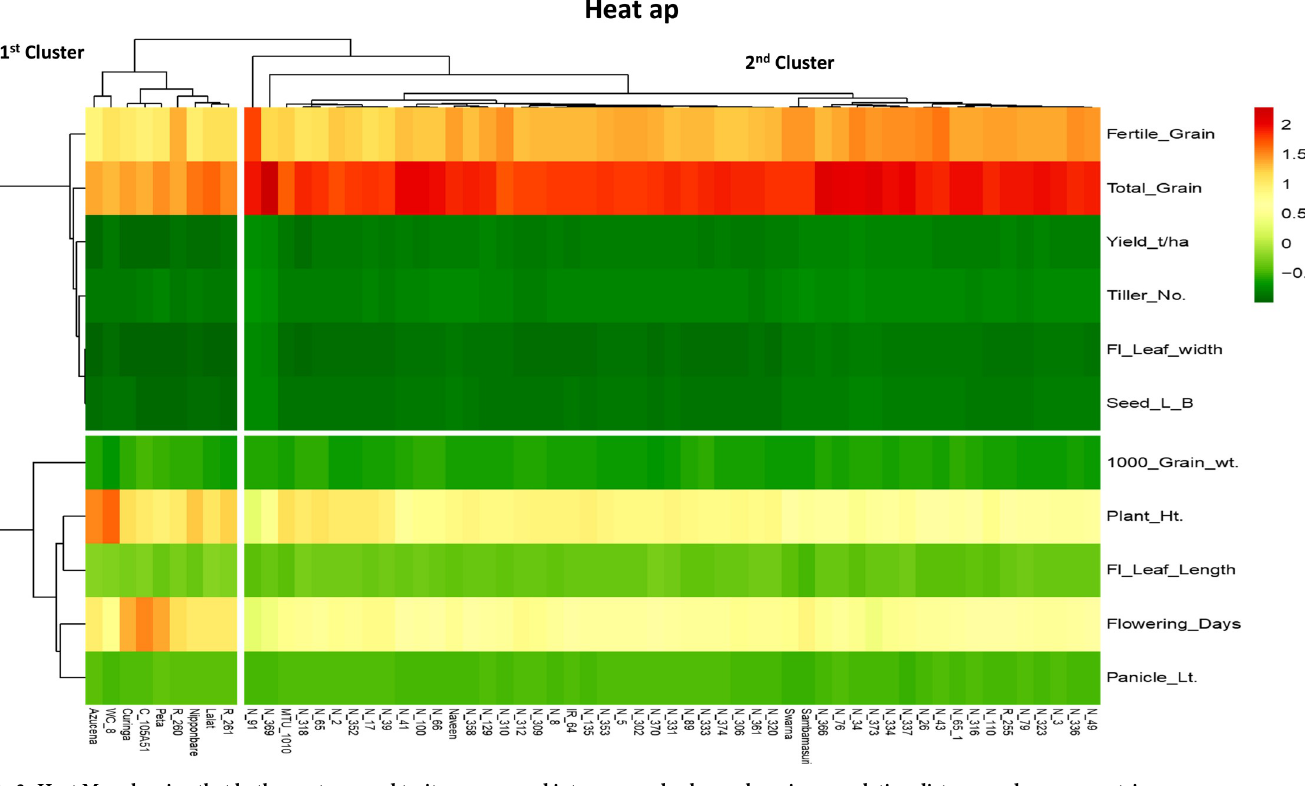
PLOS ONE | https://doi.org/10.1371/journal.pone.0227785 July 16,